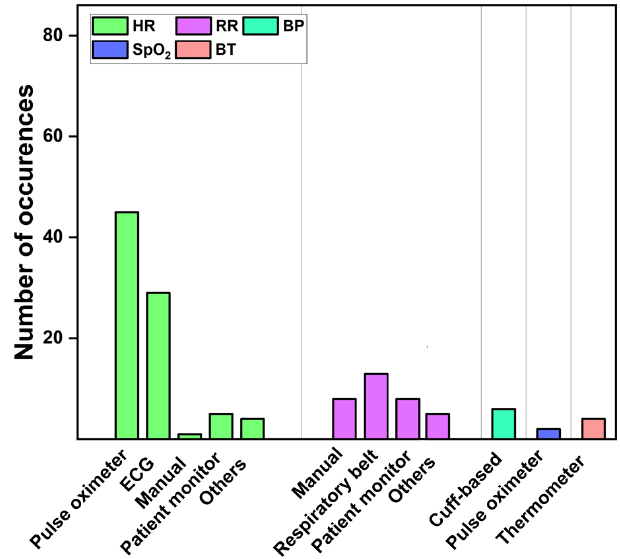
Figure 7. Distribution of ground truth.